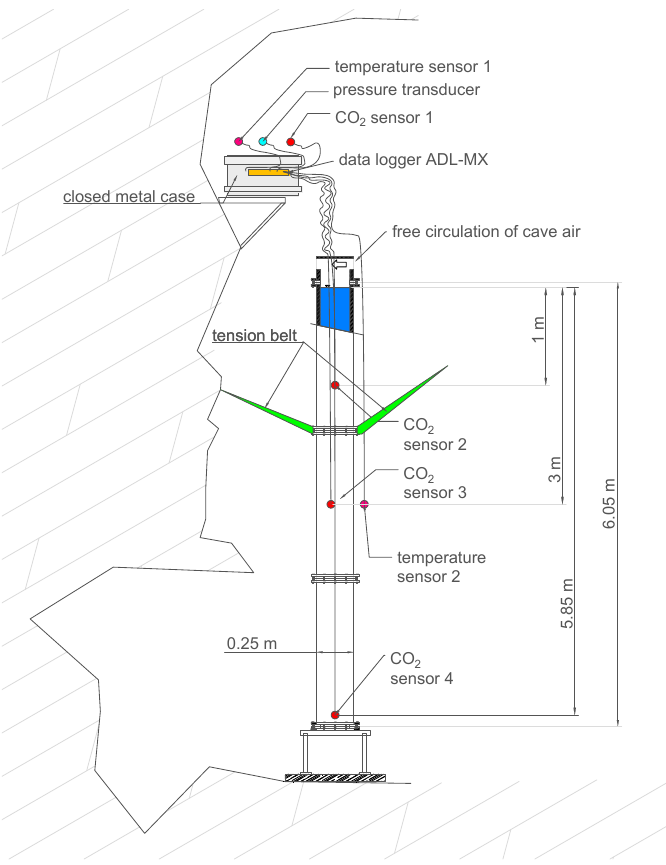
Figure 2. Schematic of the experimental